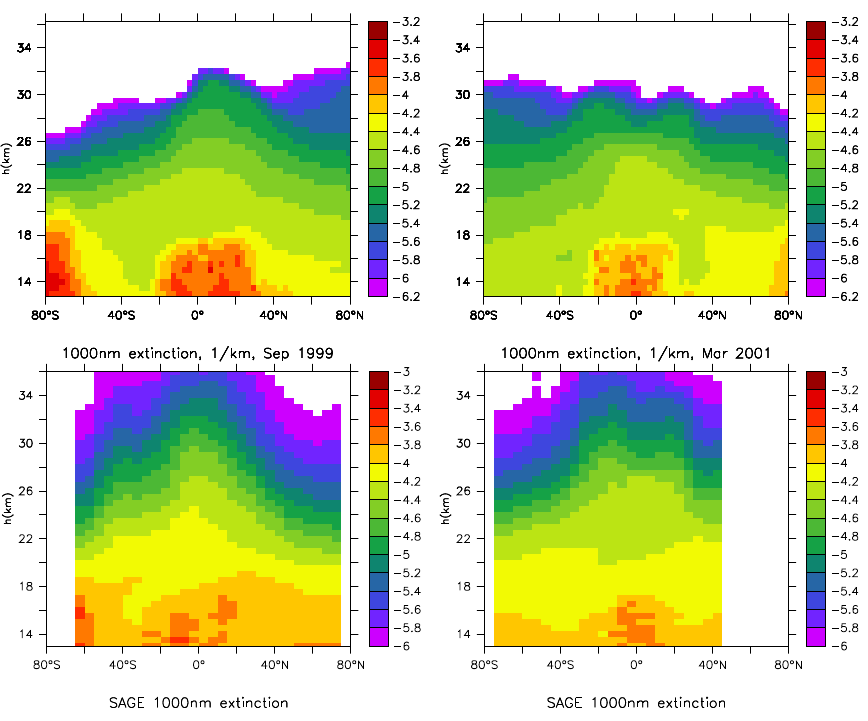
Fig. 7. Simulated (upper panels) and observed (lower panels) aerosol extinctions at 1000nm (decadal logarithm) for September 1999 (left) and March 2001 (right). Color scale for model shifted by one step to account for low bias (65%, Fig.